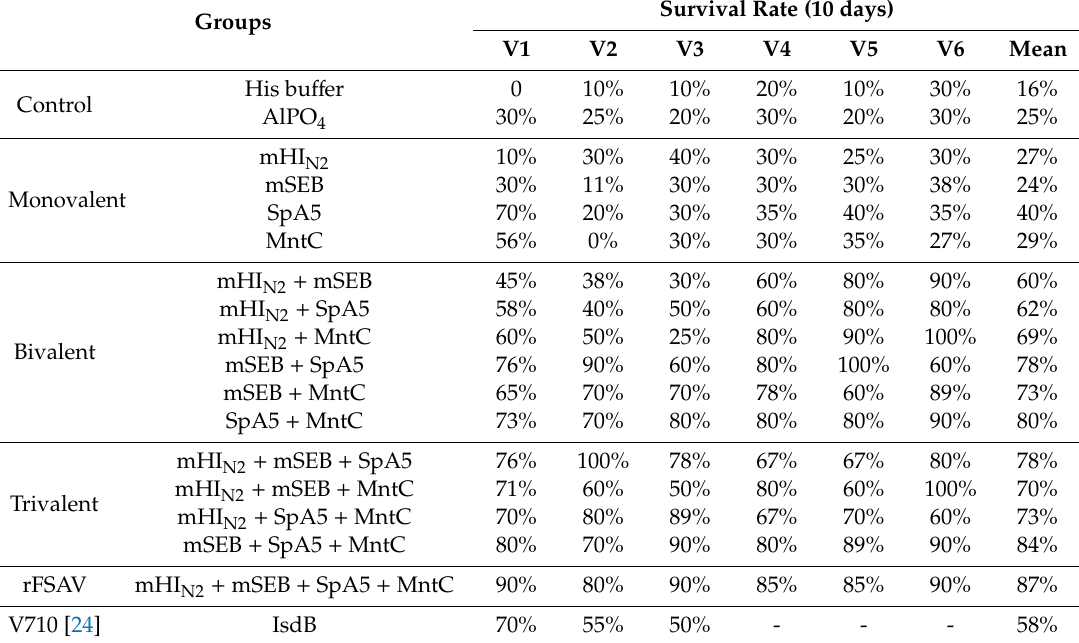
Table 1. The survival rates of recombinant five-antigen S. aureus vaccine (rFSAV) and control groups through six repetitions in a S. aureus sepsis